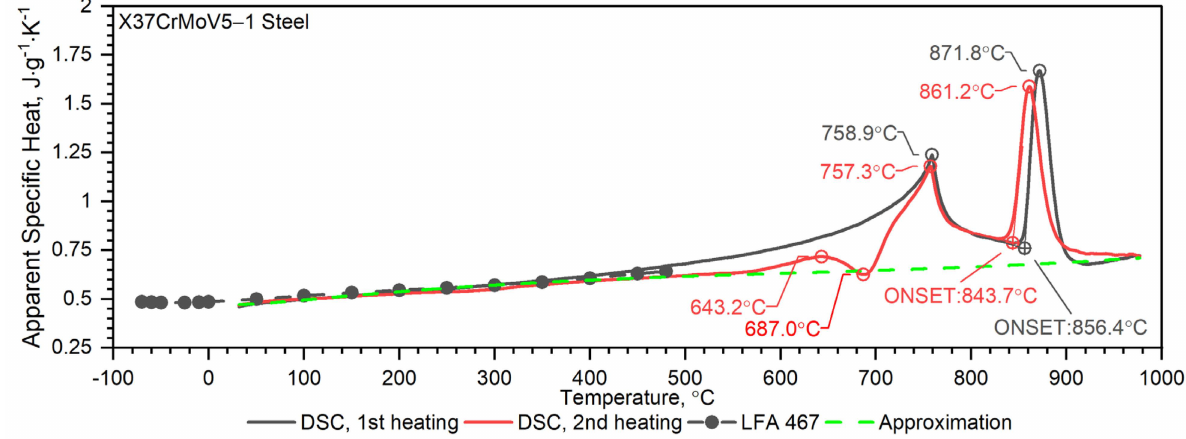
Figure 10. Temperature characteristics of apparent specific heat for the X37CrMoV5 − 1 hot-work tool steel obtained from the first and second heating run: dashed black line—results obtained from LFA 467; dashed green line—approximation of measurement on DSC.